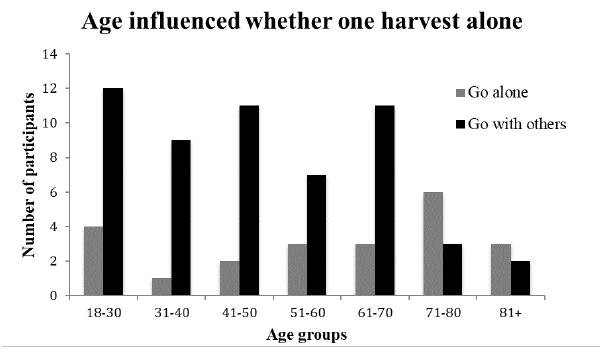
Fig. 6 . Men and women 71+ years of age harvested alone more often than men and women 18-70 years of age, X² (1, N = 77) = 10.69, p =